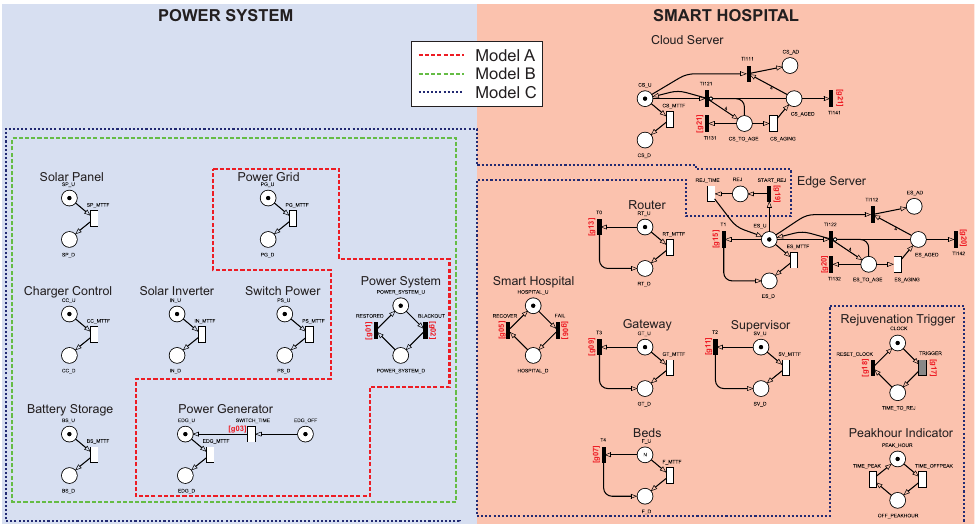
Figure 8. Reliability models created from availability models.